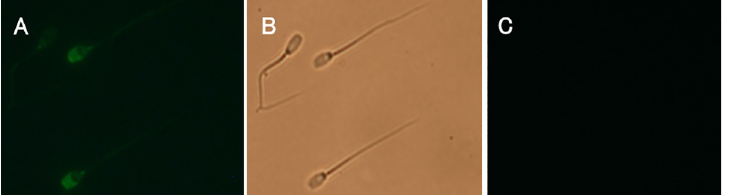
Fig 2. Indirect immunolocalization of ACRBP in fixed and permeabilized porcine sperm. Panel A indicates acrosomal fluorescent labelling detected with anti-ACRBP antibody. Panel B shows the phase contrast microscopy photo of the same field (Panel B). The non-specific fluorescence of sperm labeled with secondary fluorescein- conjugated rabbit anti-goat antibody only is displayed in Panel C. The experiment was repeated three times and representative photos are